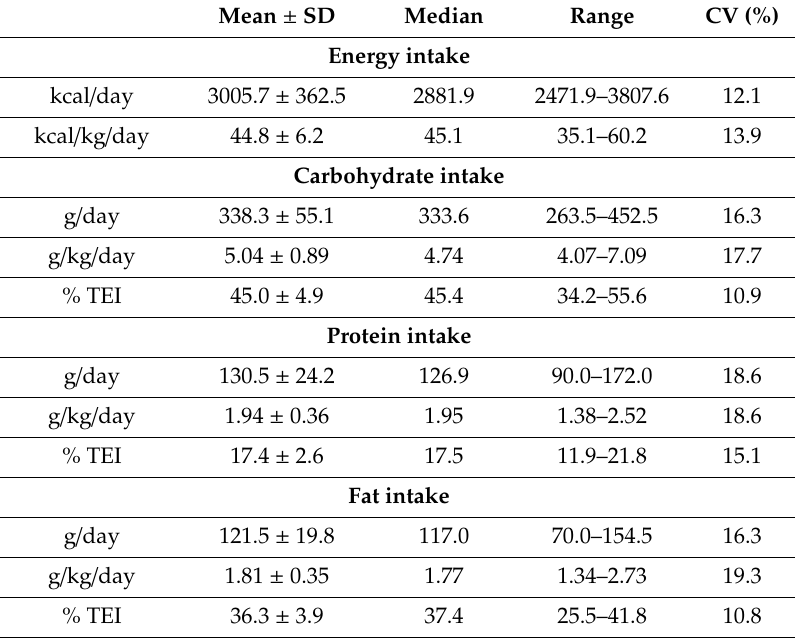
Table 3. Nutritional intake of the marathon runners during the week prior to the competition ( n = 69).